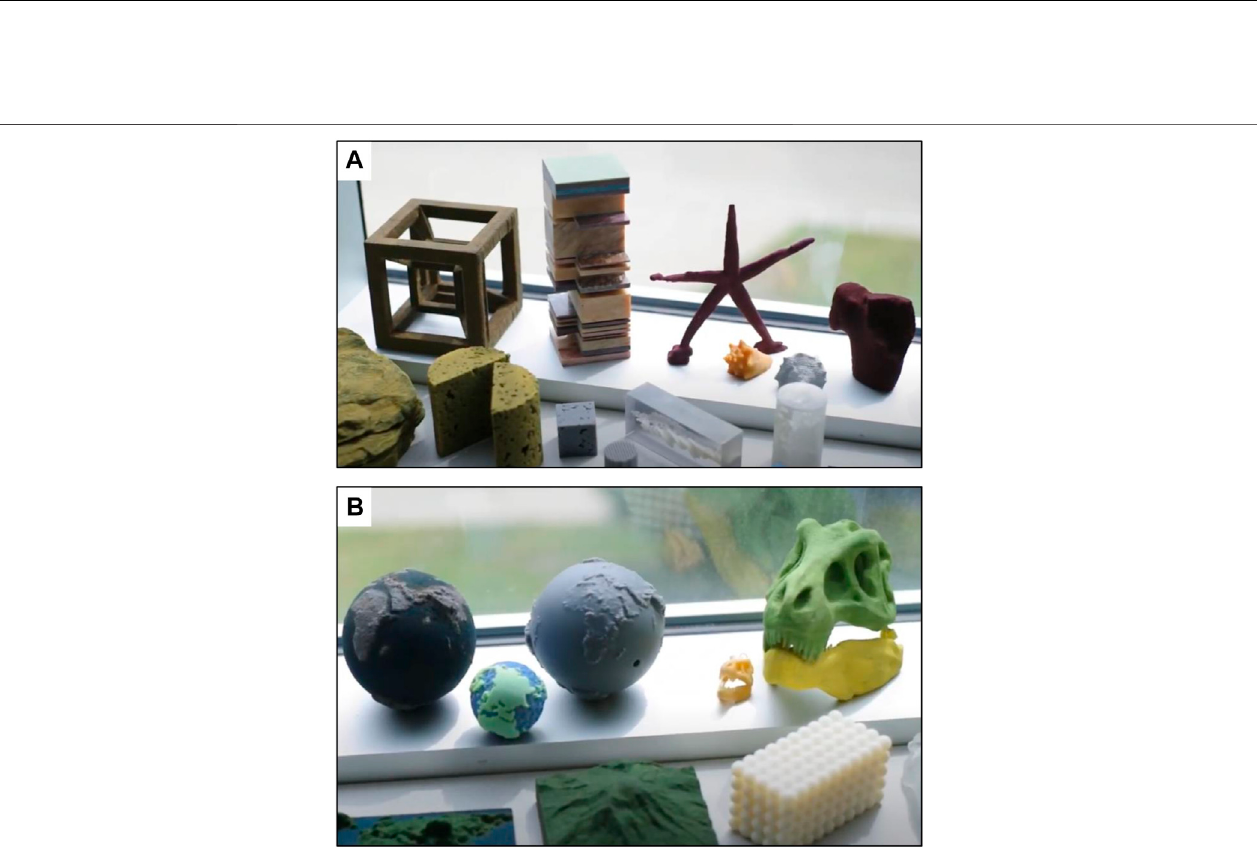
Frontiers in Earth Science |